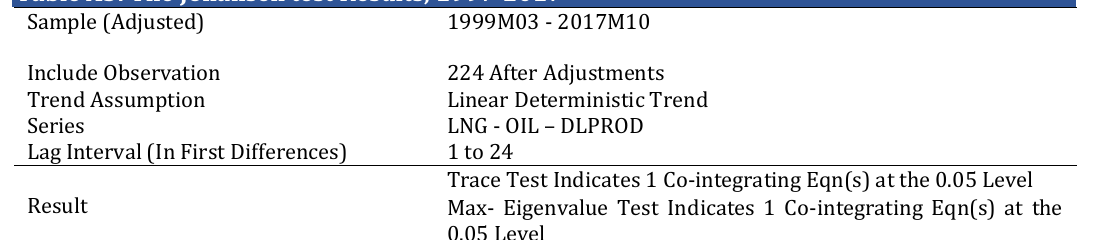
Table A3: The Johansen test Results,